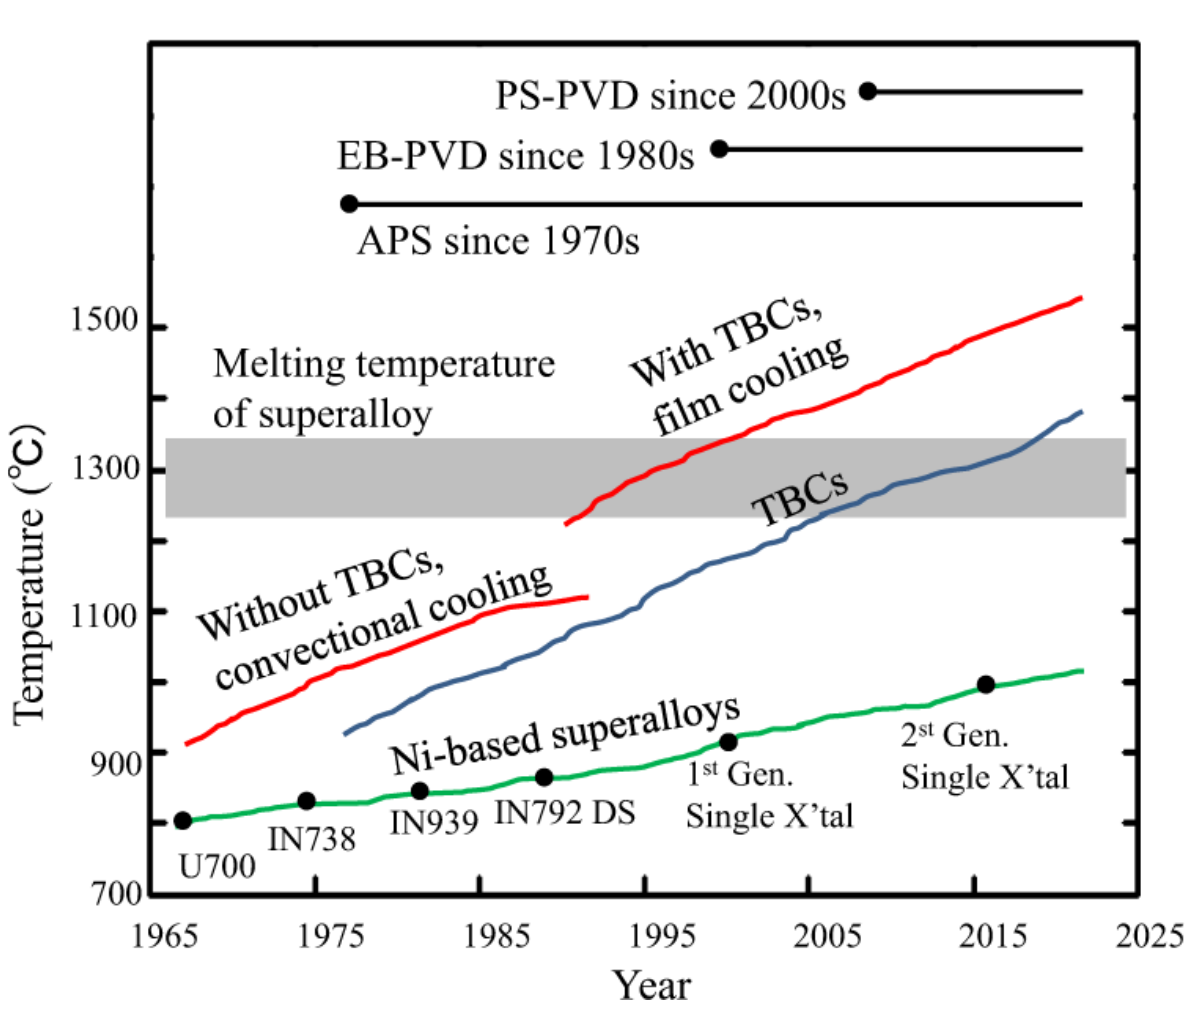
Figure 1. Modification of gas turbine engine from 1960s to current progression. Reprinted with permission from [2]. Copyright 2020 Springer Nature.